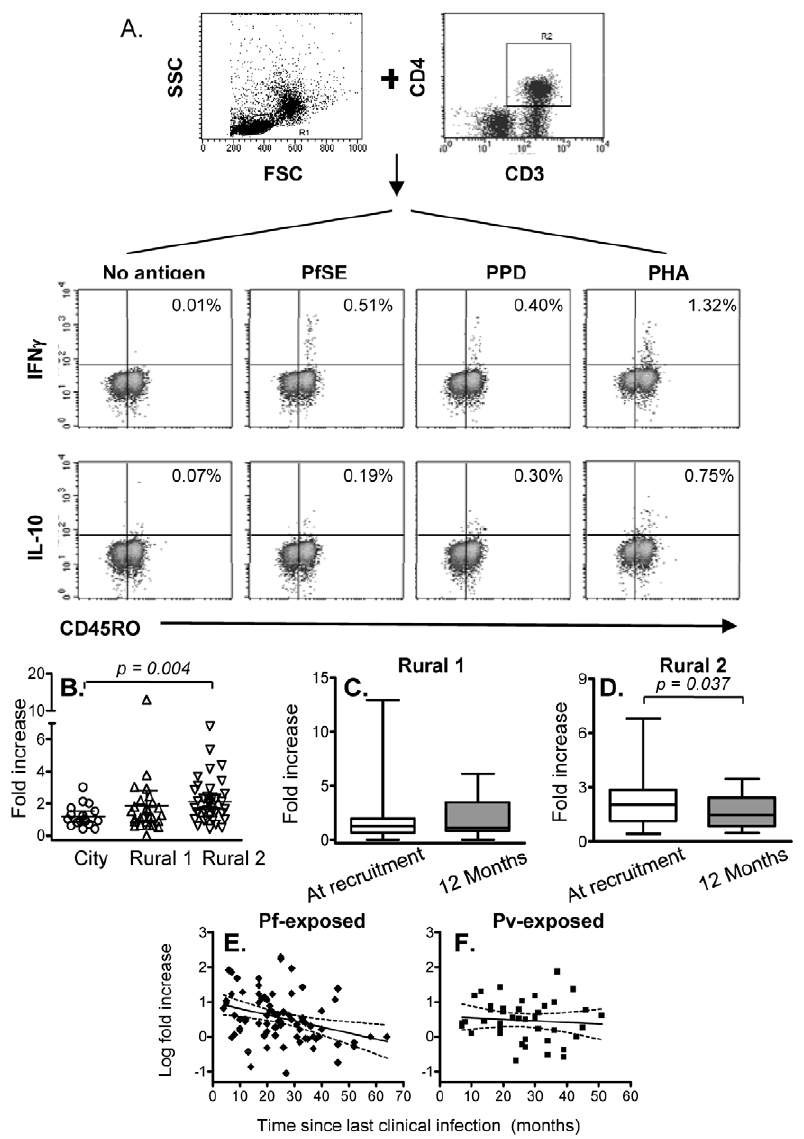
Figure 2. Immediate IFN- c and IL-10 production by effector memory CD4 T cells. PBMCs were stimulated with no antigen, PfSE, PPD or PHA for 20 hours. Cells were harvested and stained with fluorochrome-conjugated anti-CD3, CD4, CD45RO, IFN- c or IL-10 mAbs. (A) PBMC were gated by forward and side scatter and the CD3 + and CD4 + T lymphocyte population was identified. IFN- c and IL-10 production in CD45RO + populations were then determined. The plots demonstrate the results for one representative subject known to have been infected previously by P. falciparum . (B) Fold increase (mean 6 95% CI) in IFN- c production in response to PfSE (compared with cells cultured without antigen) at recruitment for each subject. Immediate IFN- c response at recruitment compared to at 12 months later in Rural 1 (C) and Rural 2 (D) subjects. [Horizontal line = median; box = 25 th and 75 th percentiles; whiskers = minimum and maximum values]. Paired t -tests were used to analyse differences between the two time points. Best-fit regression analysis of changes in fold increase of immediate IFN- c producing CD45RO + CD4 + T cells in response to PfSE over time in P. falciparum -exposed (E) and P. vivax -exposed (F) subjects. Solid lines represent best fit regression lines estimating the rates of decline of immediate cytokine responses over time and dashed lines represent the 95% CI. The median percentages of immediate IFN- c producing CD45RO + CD4 + T cells in unstimulated control cultures were 0.029, 0.031 and 0.027 in naı¨ve, Rural 1 and Rural 2 subjects, respectively.